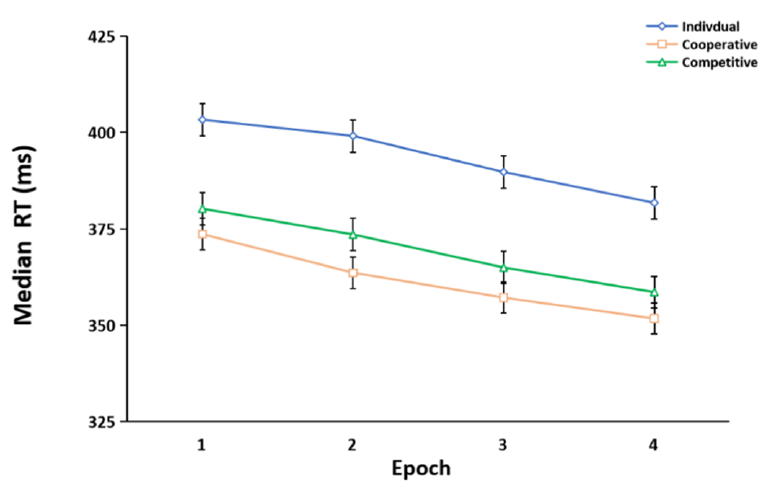
The median RTs of the four epochs for each group, analyzed by ANOVA, are shown in Figure 3. The results of ANOVA revealed a significant main effect for epoch, F (3, 225) = 42.120, p < 0.001, η 2 = 0.360. The RT decreased with epoch. Post-hoc comparisons of the epochs p revealed significant differences in the RT between epoch one and epoch four. The main effect of the group was also significant, F (2, 75) = 4.401, p = 0.016, η 2 = 0.105. Post-hoc comparisons p showed that the RTs of the cooperative group ( p = 0.006) and the competitive group ( p = 0.04) were faster than those of the individual group, but there was no significant difference between the cooperative group and the competitive group ( p = 0.501). In addition, the interaction between epoch and group was not significant, F (6, 225) = 0.298, p = 0.937, η 2 = 0.008. p